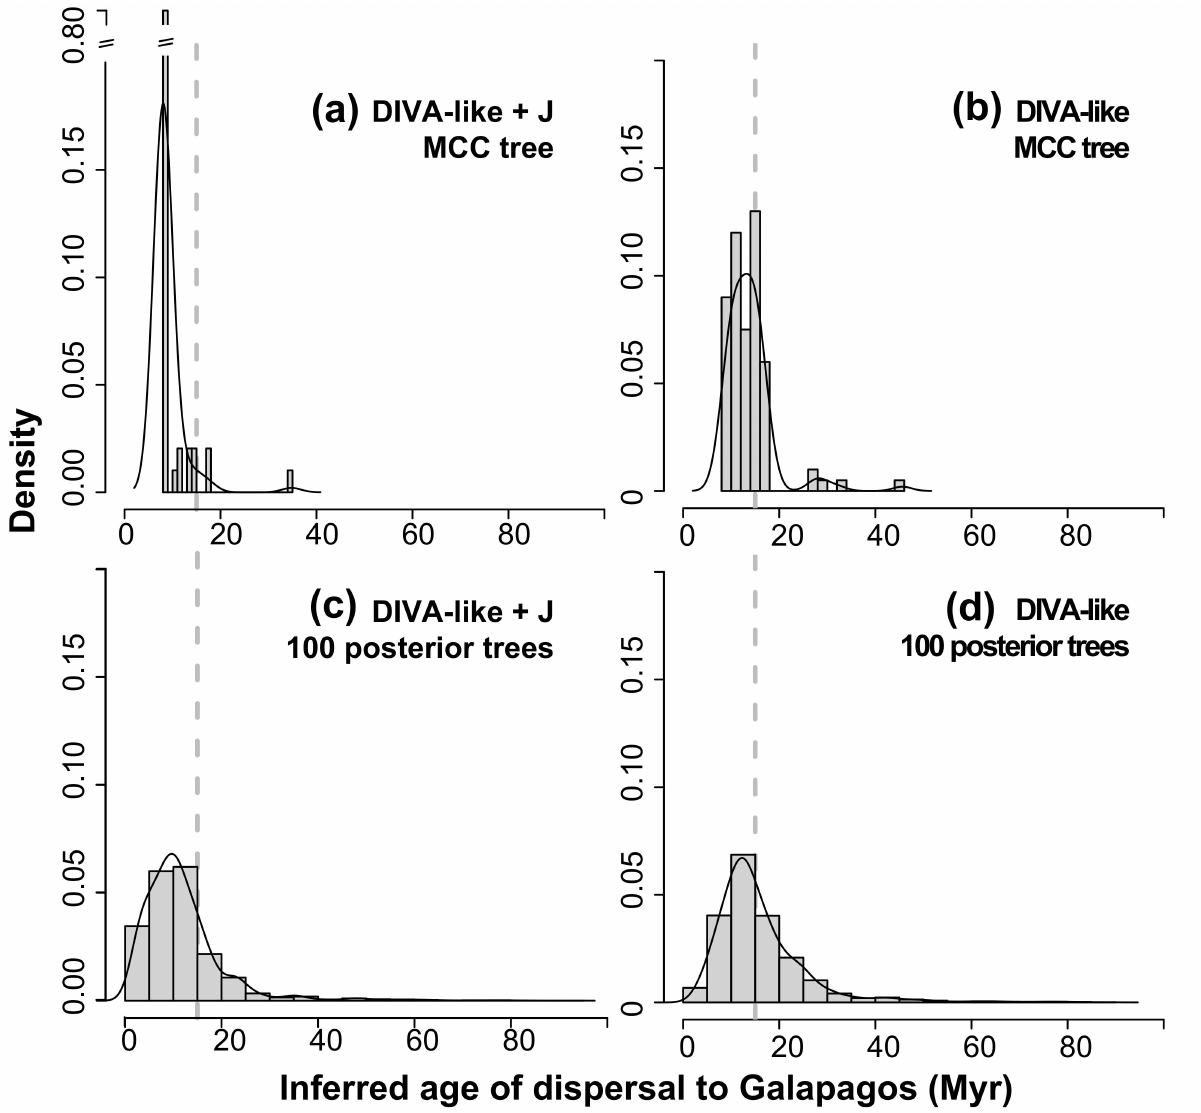
Figure 4. Histograms with the inferred age of dispersal of Sicarius to the Galapagos Islands. Analyses based on a maximum clade credibility tree (MCC tree) ( a , b ) produce sharper estimates that are closely tied to the age of split of Sicarius utriformis (from Galapagos) and its sister species. This effect is especially pronounced in the model including founder-event speciation ( a ), where 88% of the estimates have exactly the same age of that split. Accounting for uncertainty in topology and age estimates ( c , d ) reveals that the age of dispersal is much more uncertain. The dashed vertical line indicates the boundary between time slices in the time-stratified analysis and corresponds to the geological evidence of the oldest submerged paleo-islands of the Galapagos